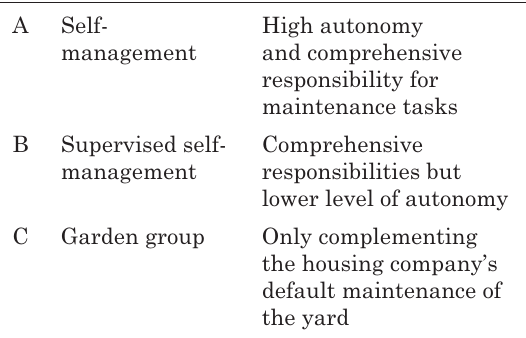
Table 1. Types of resident involvement 6 (drawn from Castell,